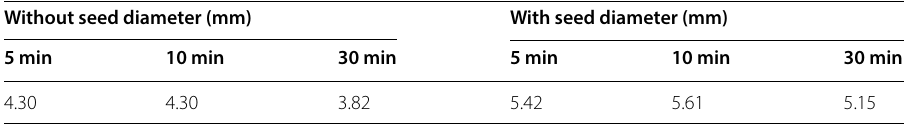
Table 6 Volume-based mean diameter of silica precipitation process Without seed diameter (mm) With seed diameter